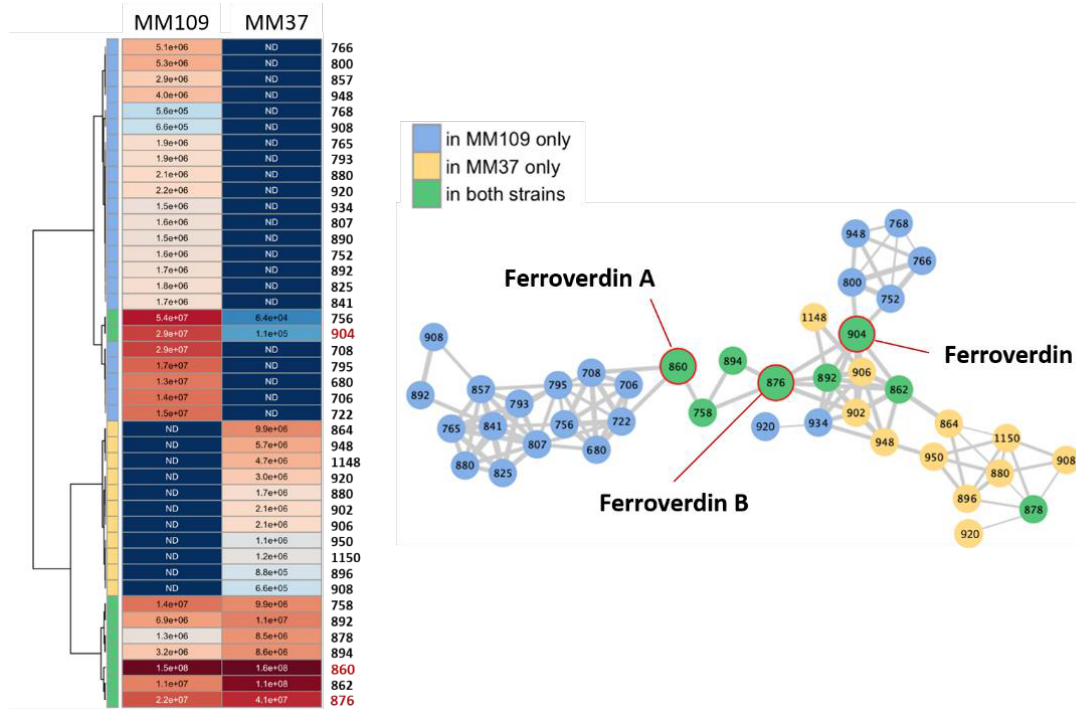
Figure 9. Molecular network and production levels of ferroverdins produced by S. lunaelactis strains MM37 and MM109. The molecular network was generated by the GNPS software and manually curated as described in the text. The heatmap on the left reflects the intensity of each of the 41 ferroverdin-like compounds.